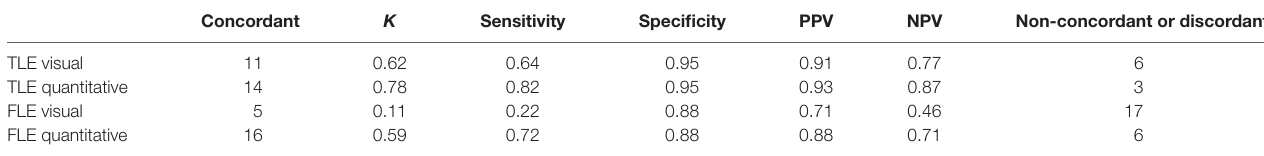
TaBle 2 | Summary of visual and quantitative positron emission tomography analyses as compared to the location of the epileptogenic zone.